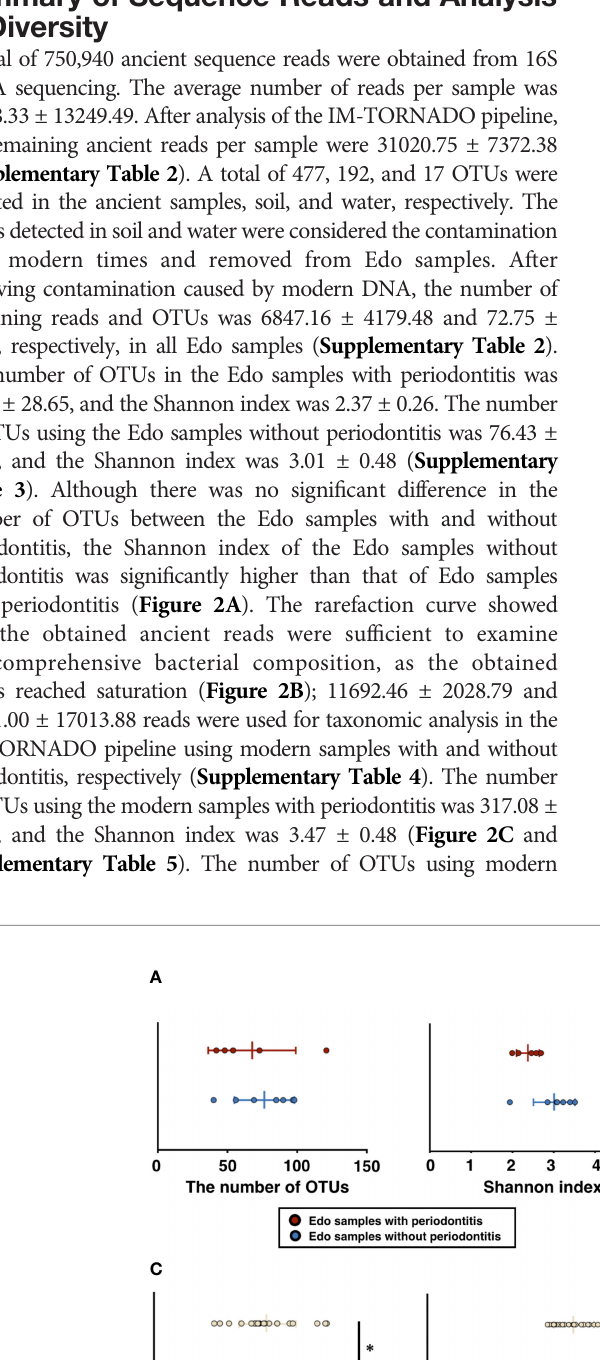
Frontiers in Cellular and Infection Microbiology |